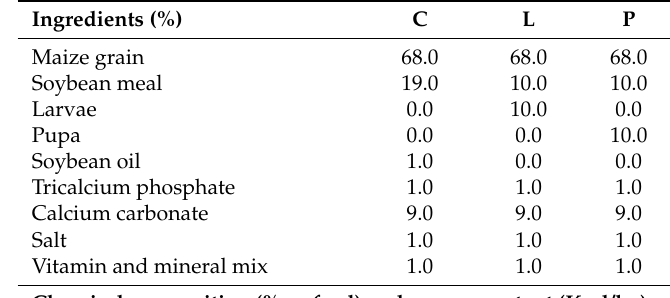
Table 2. Ingredients and chemical composition of the experimental